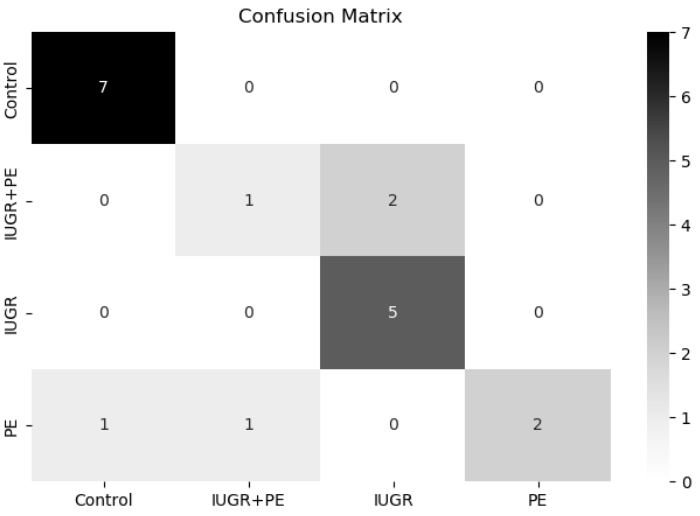
Figure 6. Confusion matrix for the extra-tree classifier model. The multi-label output was decoded to see the prediction performance for each class.